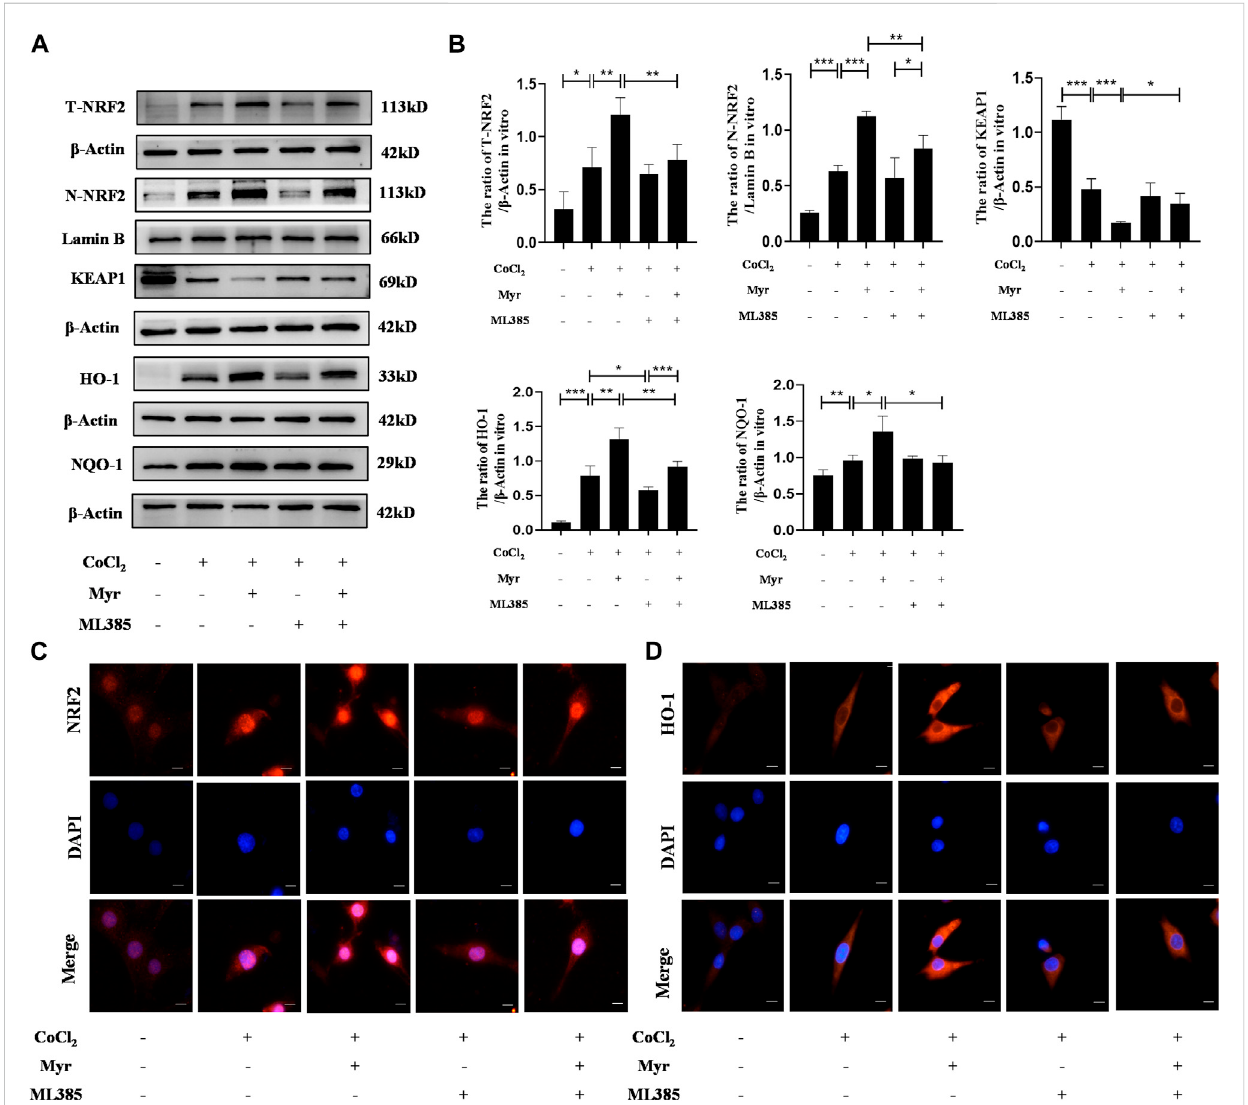
FIGURE 7 Myricetin exerted neuroprotection through the activation of NRF2 pathway. (A) The protein bands of T-NRF2, N-NRF2, KEAP1, NQO-1, and HO-1 were detected by Western blot in PC12 from each group. (B) Quantitative analysis of Western blot bands ( n = 4 per group). (C) The representative immuno fl uorescence staining images of NRF2 (red) in PC12 from each group. Nucleus were stained with DAPI (blue). (D) The representative immuno fl uorescence staining images of HO-1 (red) in PC12 from each group. The data are presented as mean ± SD. * p < 0.05, ** p < 0.01, *** p < 0.001. Scale bar: 10 μ